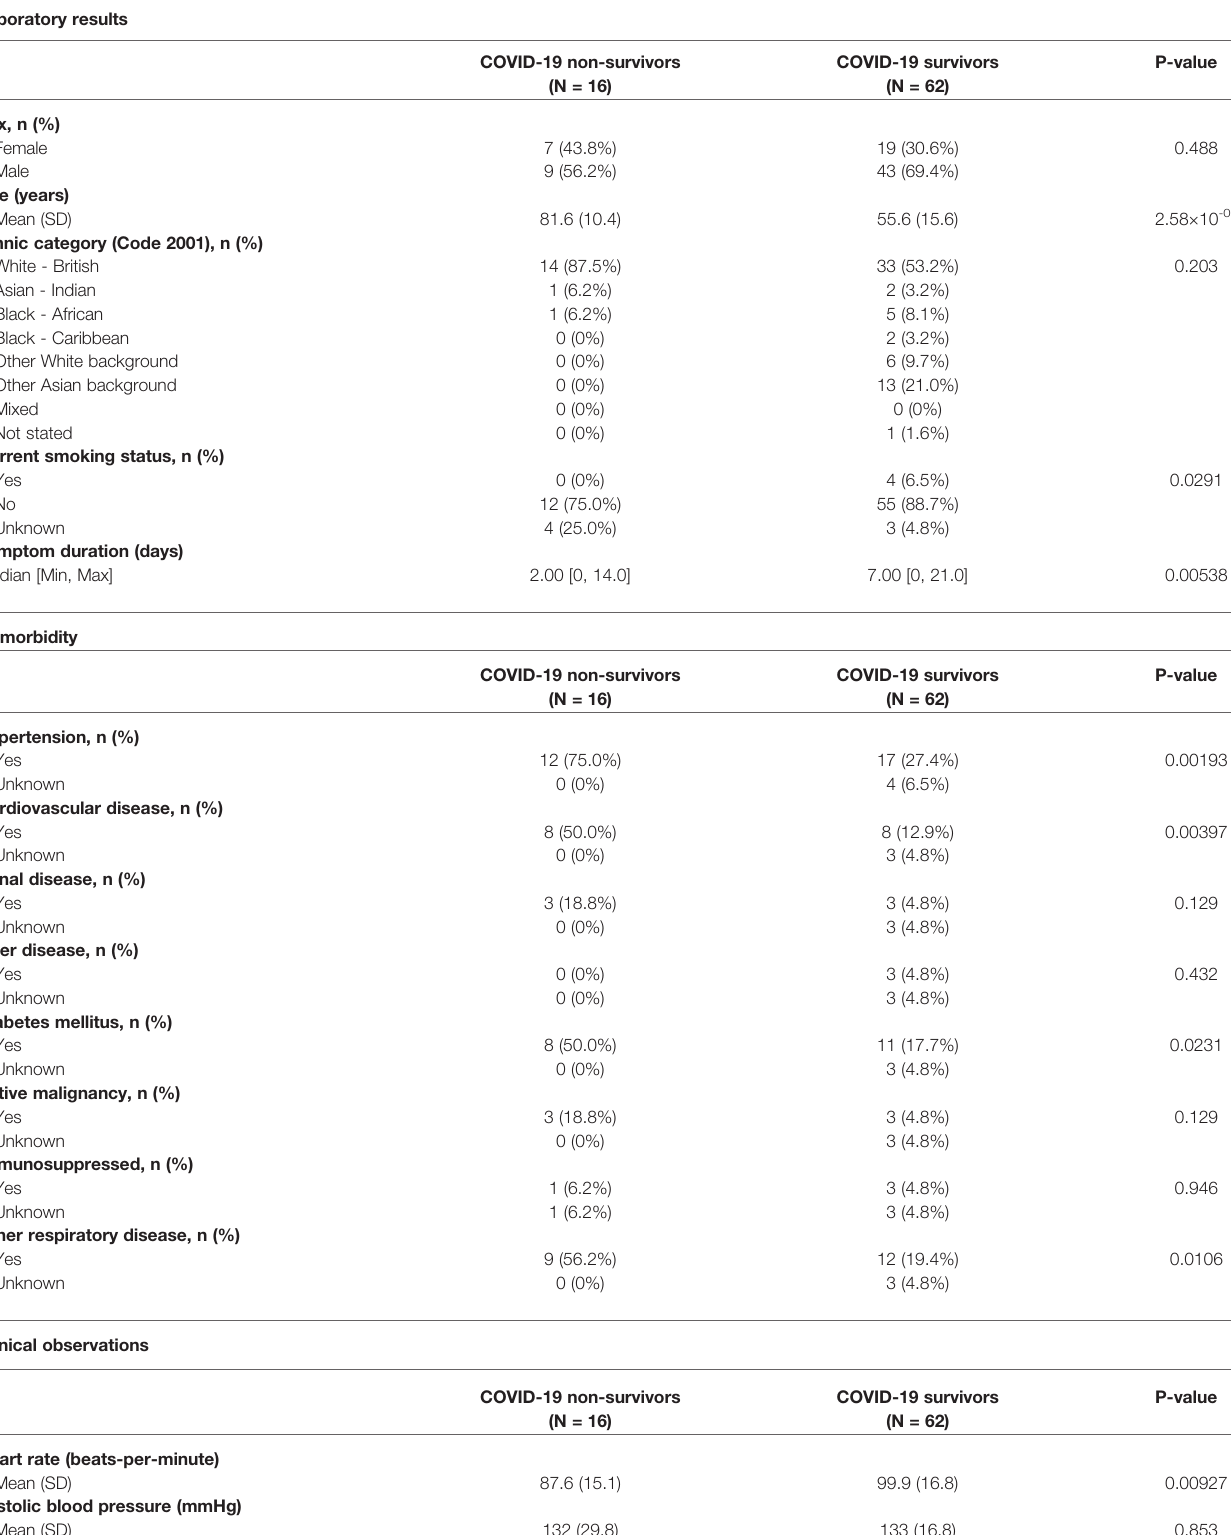
TABLE 2 | Baseline clinical characteristics and outcomes of hospitalised COVID-19 patients: survivors versus